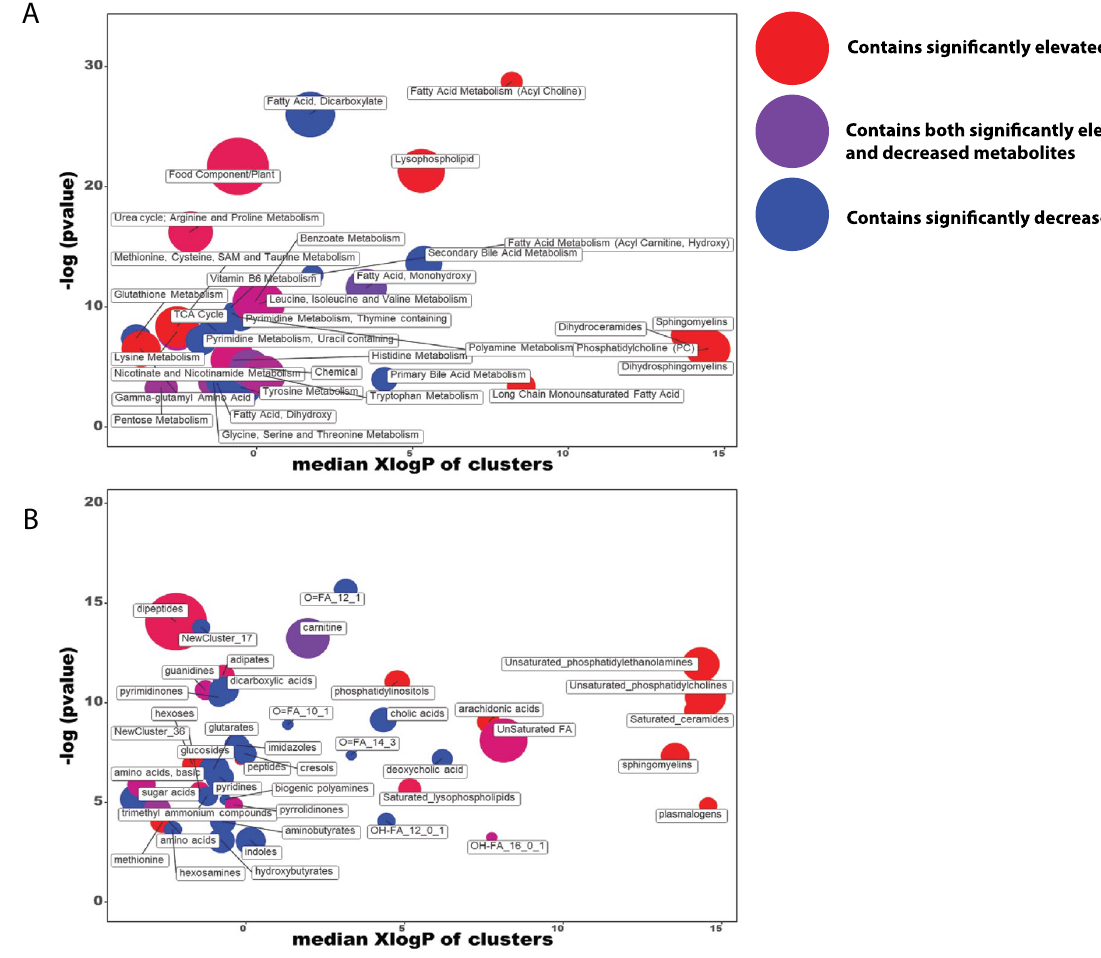
Figure 3. Chemistry-driven functional clustering yields different results from biochemically defined subpathway enrichment. ( A ) ChemRICH analysis of all the significantly altered compounds under Ahr −/− versus Ahr +/+ conditions with the Metabolon-defined subpathways echoes the results of the pathway enrichment, with a combination of elevated and decreased pathways being statistically altered. ( B ) Novel functional clusters were generated for each metabolite with a known chemical structure based on similarity to other measured metabolites. The most altered pathways differed from those defined by Metabolon’s biochemically-based subpathways, revealing that dipeptides, carnitine derivatives, and dicarboxylic acids were the most significantly impacted metabolic functional clusters. In both panels, the size of each point represents the number of compounds within the subpathway/functional cluster, the color represents the proportion of significantly increased/decreased compounds within the cluster, where blue points have more decreased compounds, purple points have elevated and decreased compounds, and red points have more elevated compounds, with intermediate colors between these representing different ratios. The x-axis is the median XlogP (relative lipophilicity based on the enhanced atomic partition coefficient) of all the compounds within the cluster, and the y-axis is the -log of the p -value, as calculated by the Kolmogorov–Smirnov